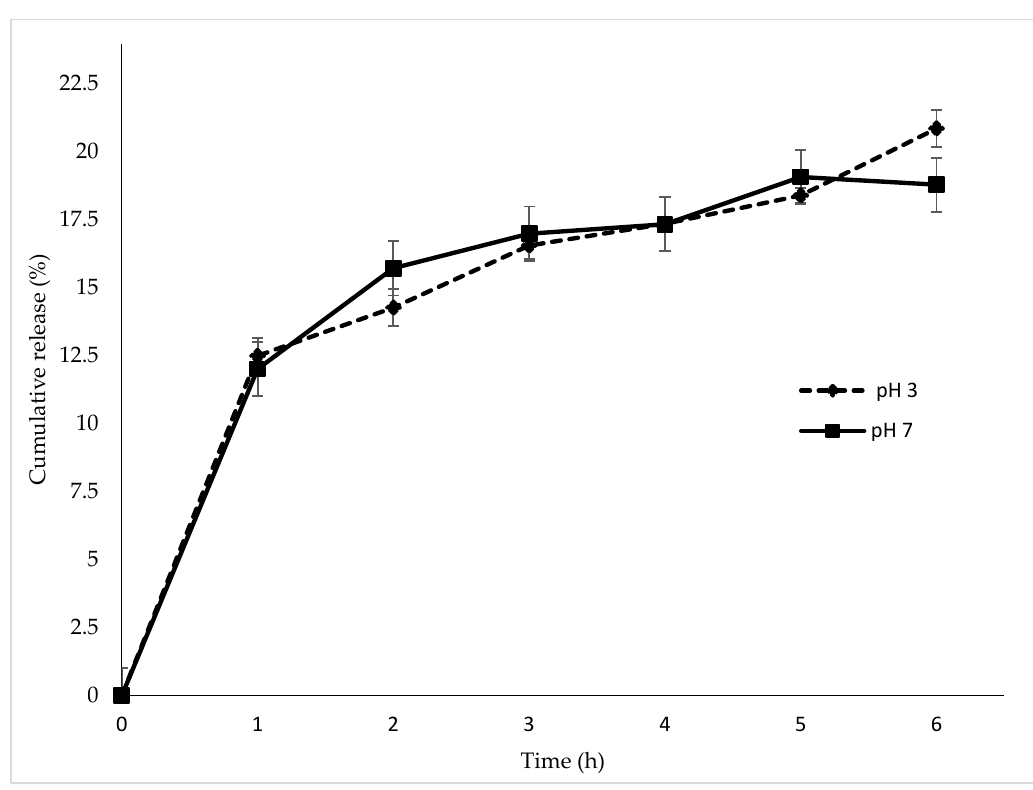
Figure 7. Chincho essential oil released (%) from chitosan nanoparticles organogel system obtained from optimization process in acetate and phosphate buffers (pH 3 and pH 7).